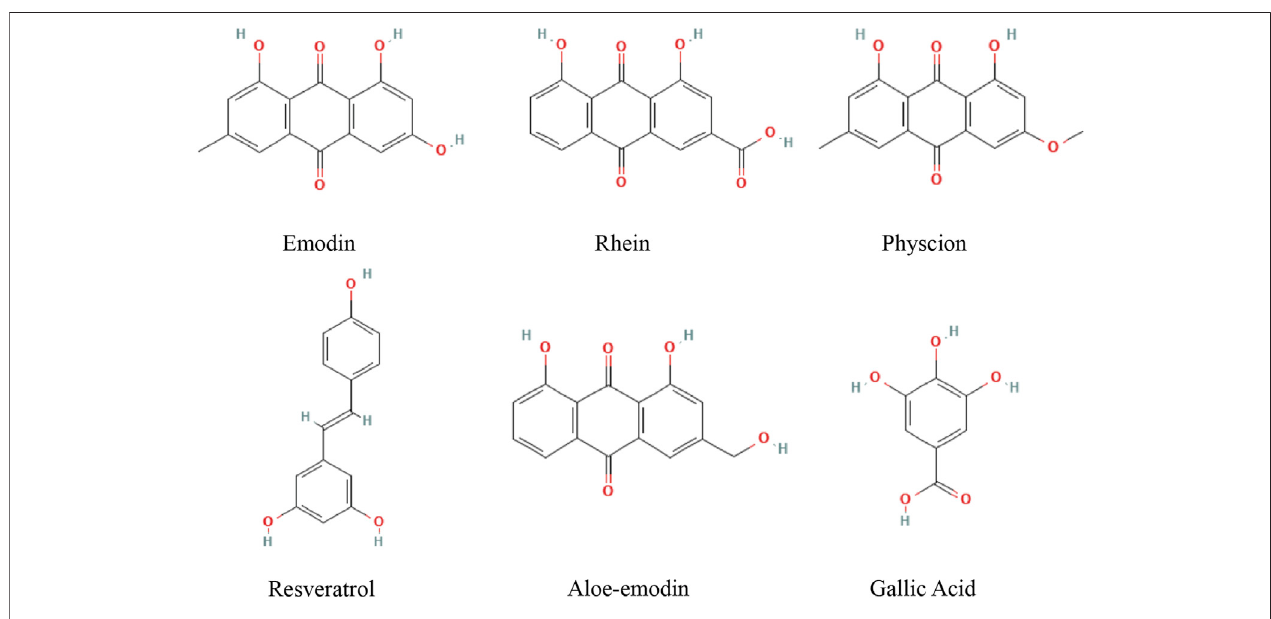
FIGURE 1 | Chemical structures of active metabolites of